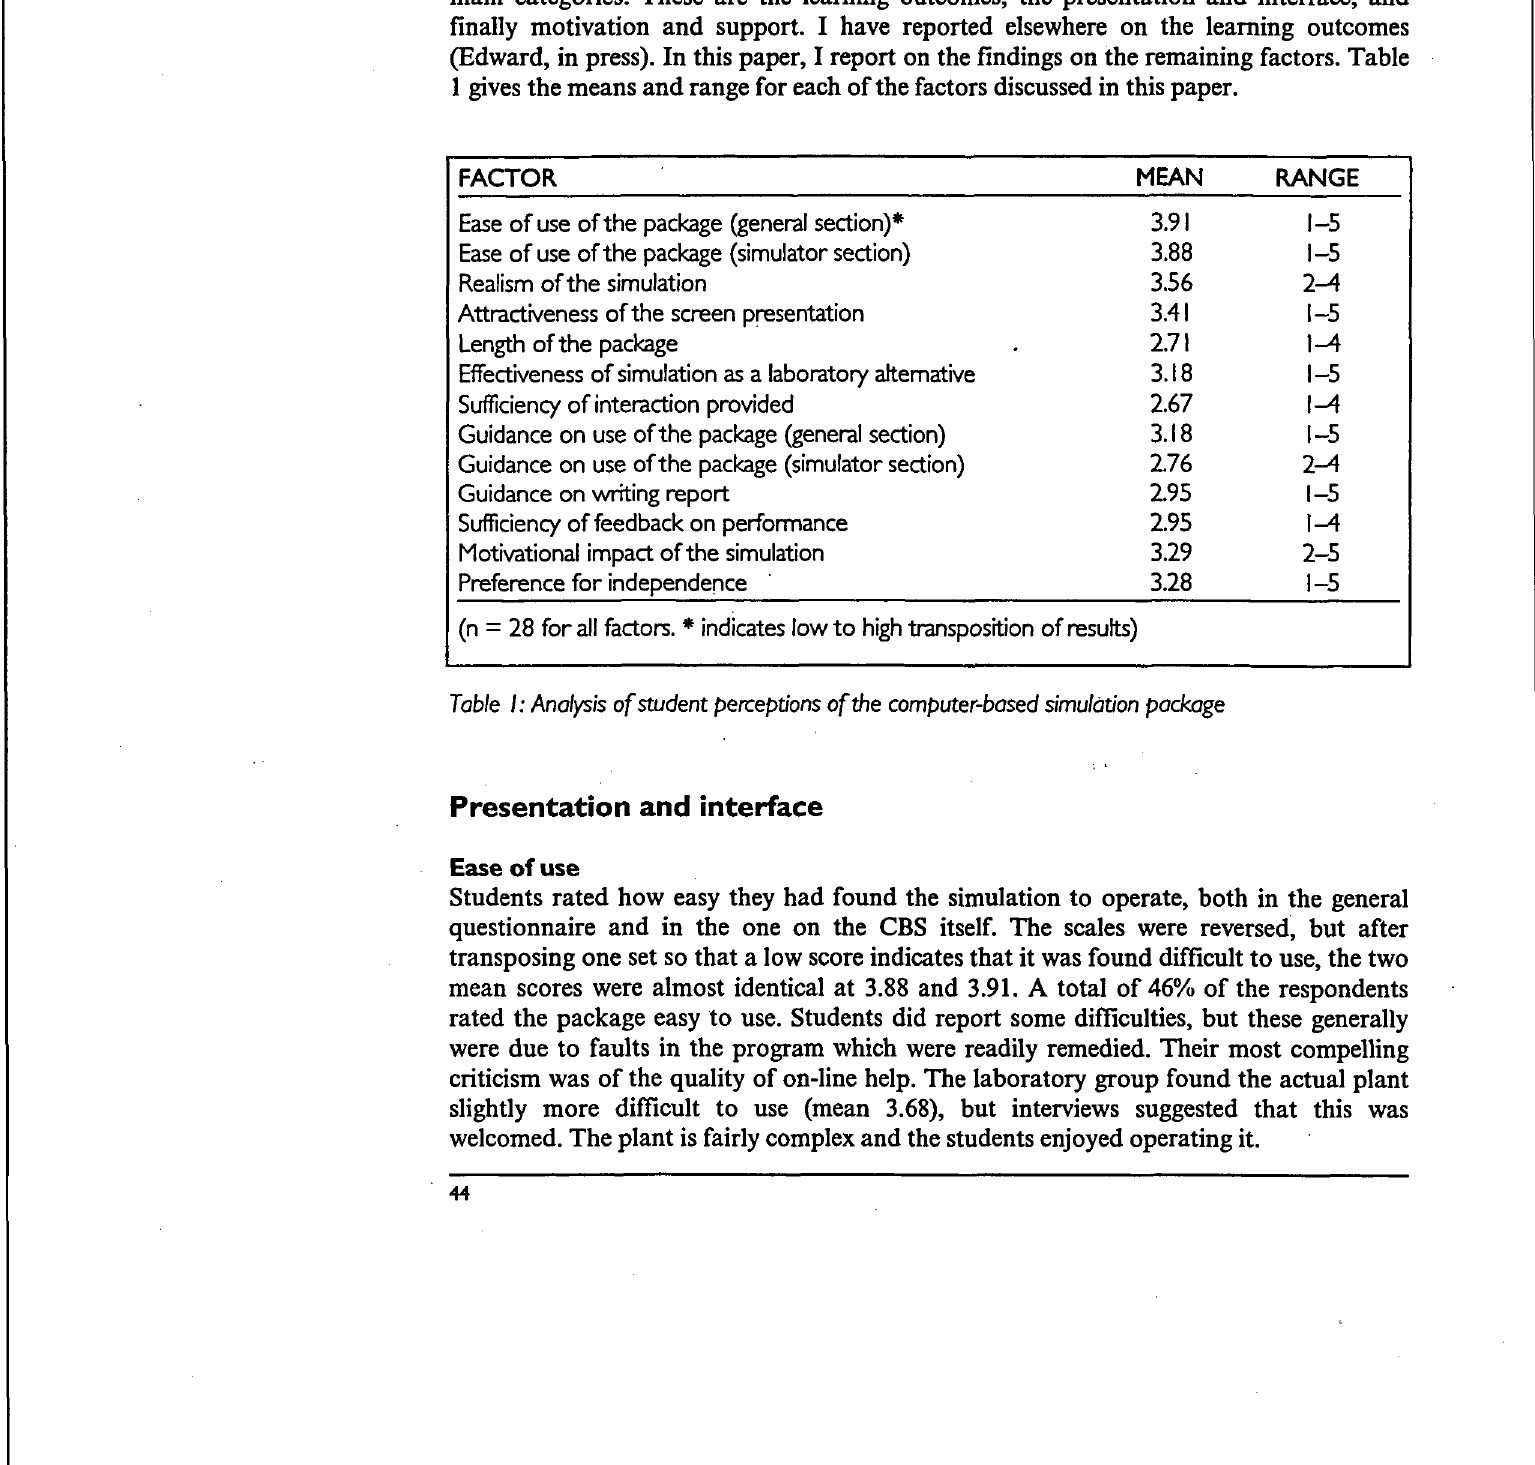
Presentation and